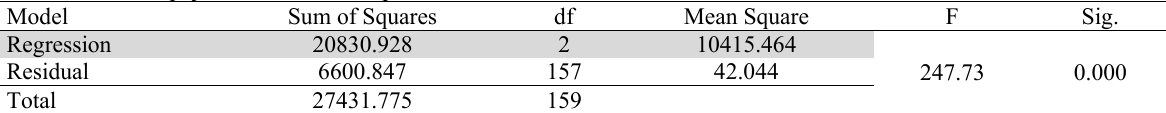
ANOVA leadership, job satisfaction and performance